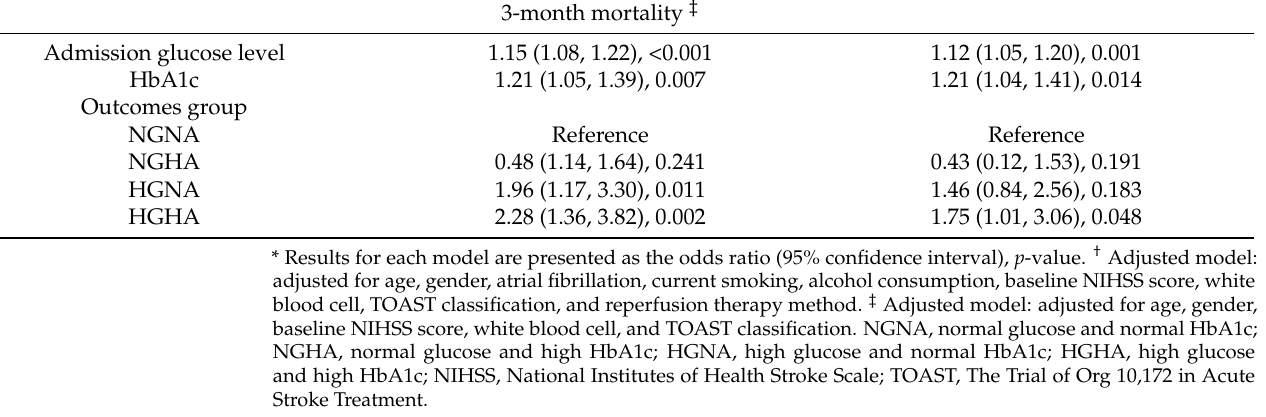
with the reference group. After adjusting for age, gender, baseline NIHSS score, smoking, atrial fibrillation, white blood cell count, and reperfusion therapy method, the association between HGHA and mRS score remained significant (OR, 1.61; 95%CI, 1.07–2.42; p = 0.023, Figure 2). The shift toward worse outcomes in favor of the intervention was consistent for all categories of the mRS, except for no symptoms (mRS = 0) (Figure 2).